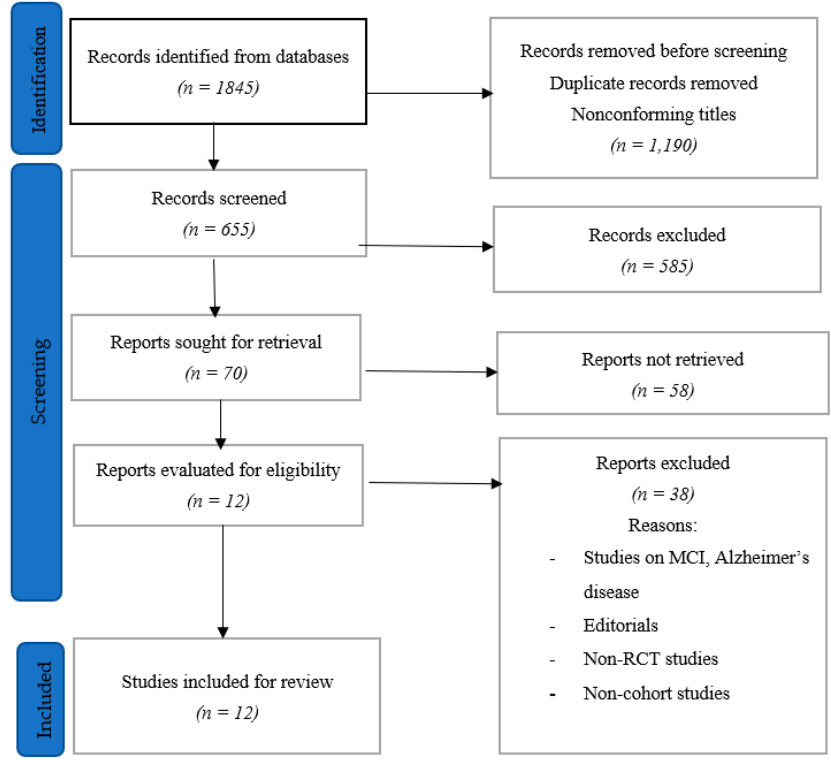
Figure 1. Study selection process.